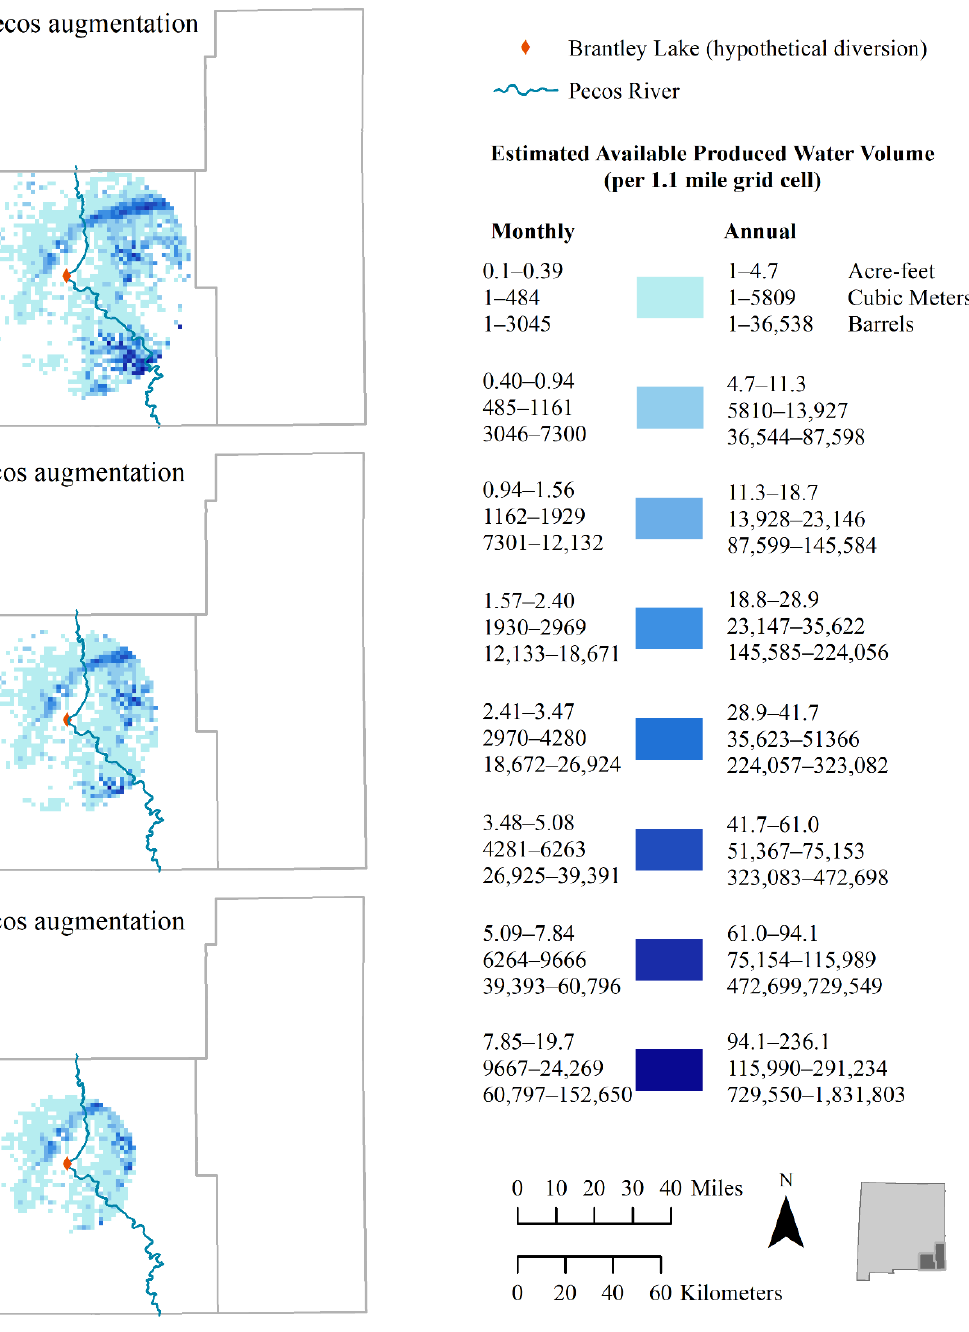
Figure 10. Area of collection required based on estimated supply to meet 100%, 50%, and 25% of the water demand for Pecos River augmentation.